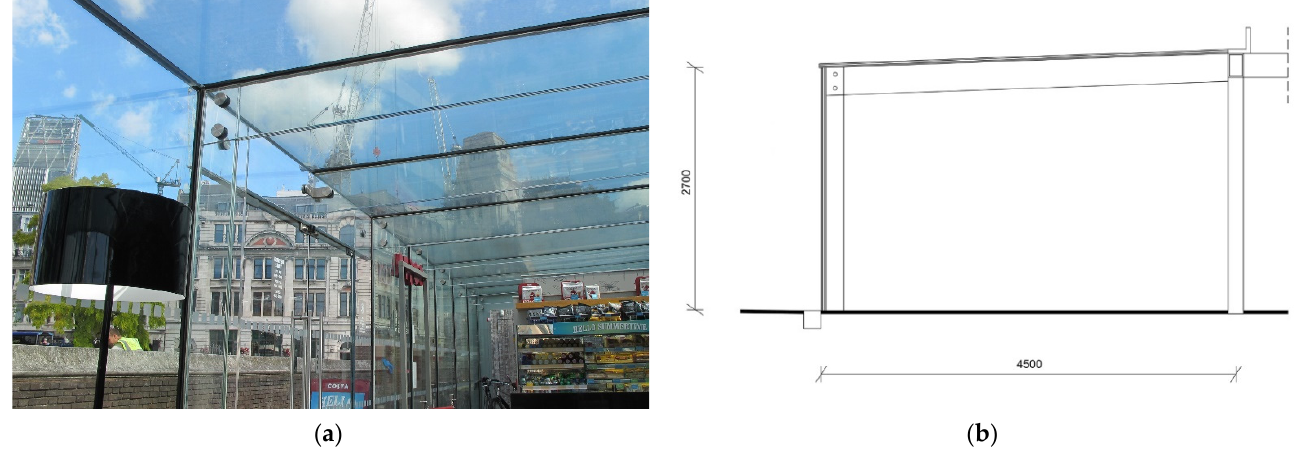
Figure 20. The Costa Coffee London: ( a ) view inside the glass pavilion (photo by the author); ( b ) glass frame geometry (figure by the author). frame geometry (figure by the